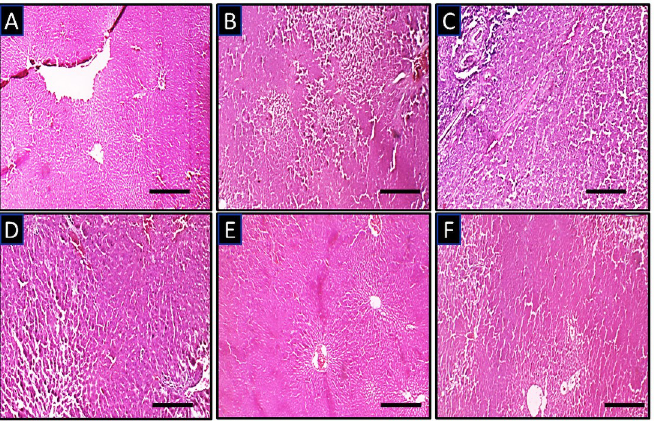
Fig 7. Representative photomicrographs of the liver of experimental animals showing the general histomorphology. (A) na ï ve control group (B) unheated oil treated group (C) heated oil only treated group as negative control, (D) heated oil in addition to atorvastatin 25 mg/kg (E) heated oil in addition to celecoxib 5 mg/kg and (F) heated oil in addition to celecoxib 10 mg/kg. Scale bar is 50 μ .